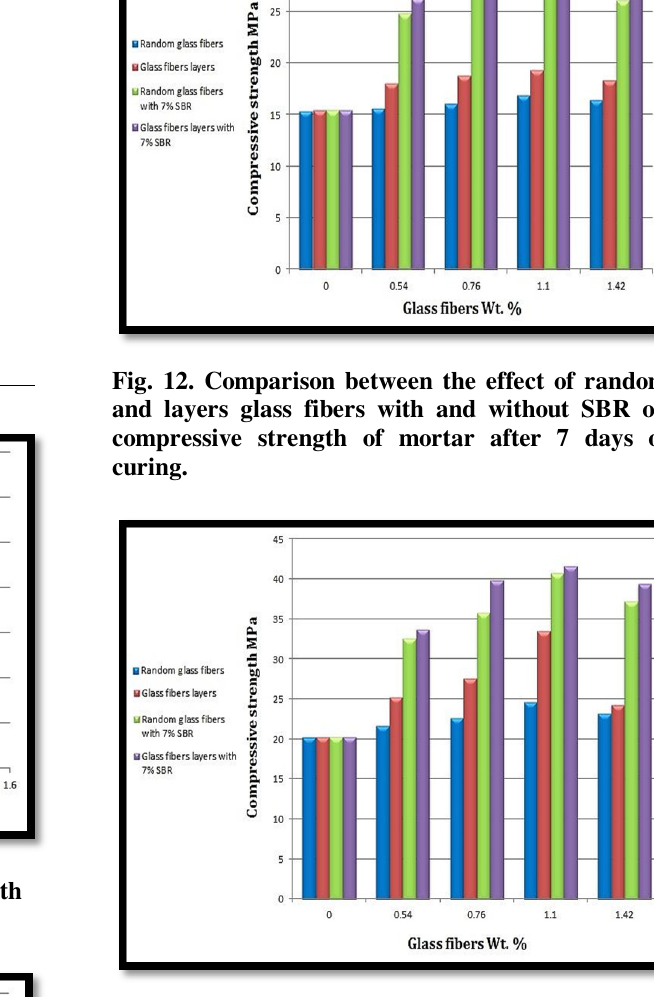
Fig. 13. Comparison between the effect of random and layers glass fibers with and without SBR on compressive strength of mortar after 7 days of